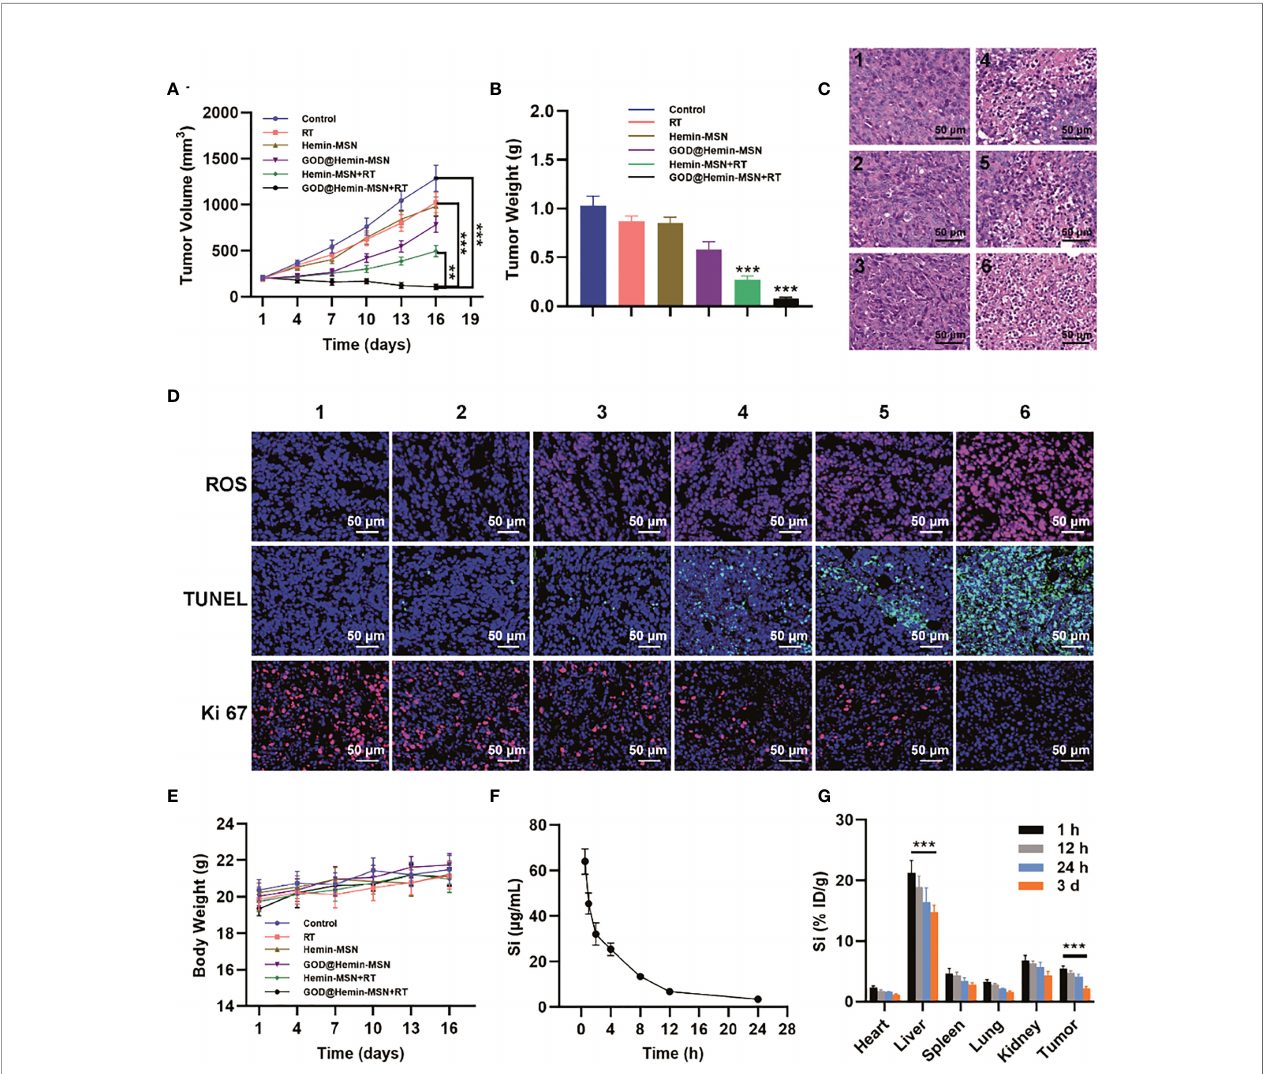
FIGURE 3 | Radiosensitization in vivo in tumor xenograft mice. (A) Tumor volume changes. (B) Tumor weights. (C) Hematoxylin – eosin (H&E) staining of the tumor slices [group 1 , control; group 2 , radiotherapy (RT); group 3 , hemin-MSN; group 4 , GOD@Hemin-MSN; group 5 , hemin-MSN+RT; and group 6 , GOD@Hemin- MSN+RT]. (D) Immuno fl uorescence staining. (E) Body weights in each group. (F) Pharmacokinetic curves. (G) Biodistribution at 1, 12, and 24 h and at 3 days post- injection of GOD@Hemin-MSN [the same groups as in (C) ]. Data are presented as the mean ± SD using one-way ANOVA with Tukey ’ s multiple comparison tests. *** p < 0.001; ** p <